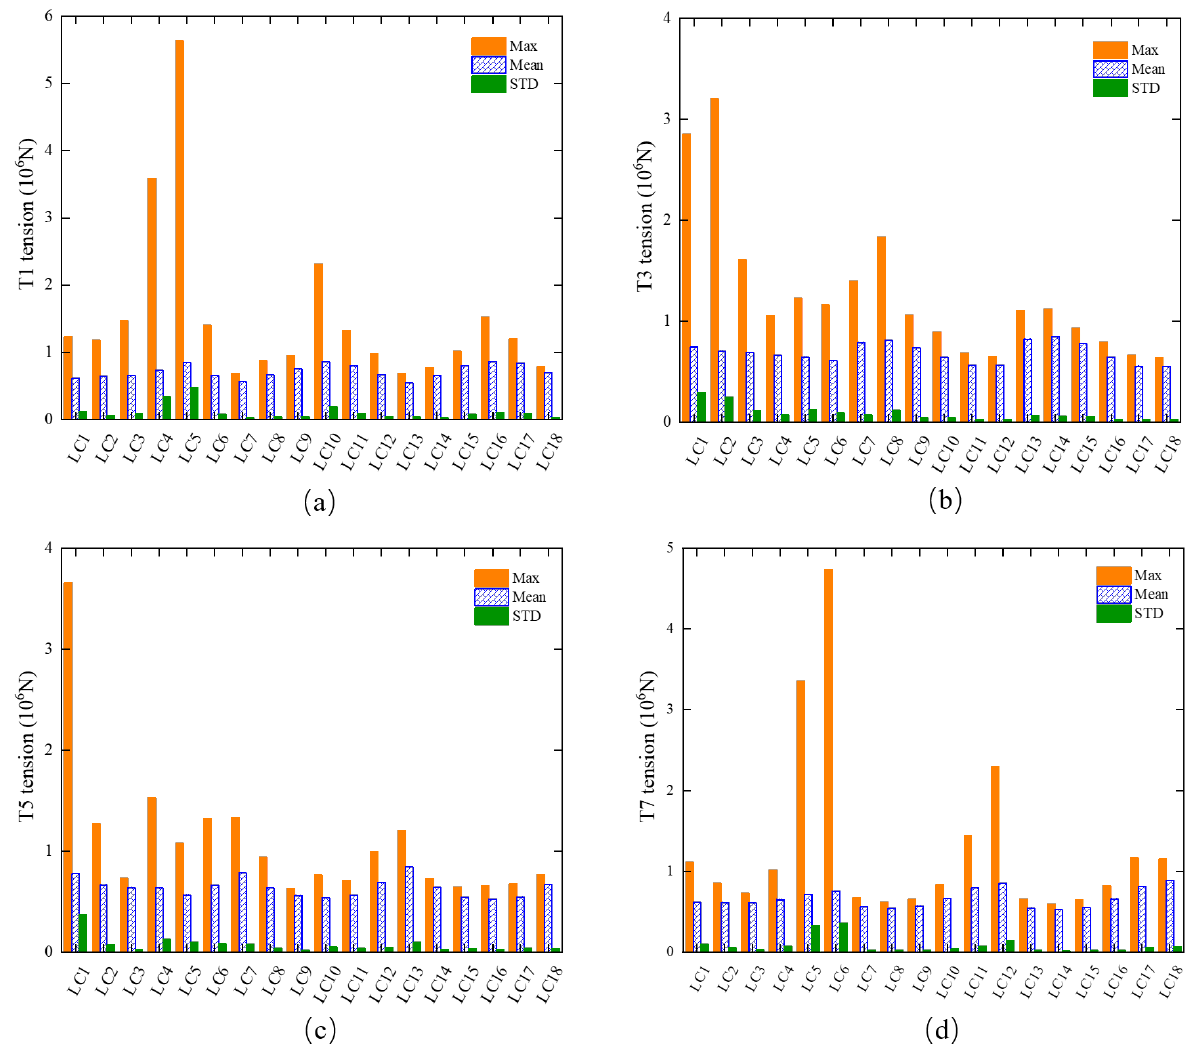
Figure 15. Statistics of mooring line top tension for ( a ) T1, ( b ) T3, ( c ) T5, and ( d ) T7.